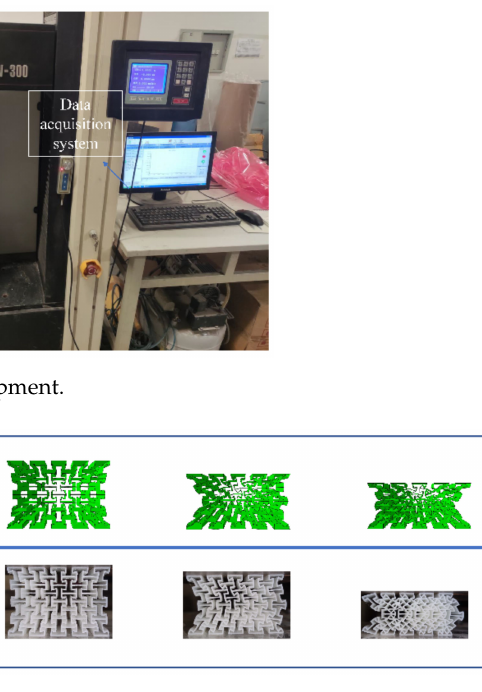
Figure 10. Structural compression processes: simulation and